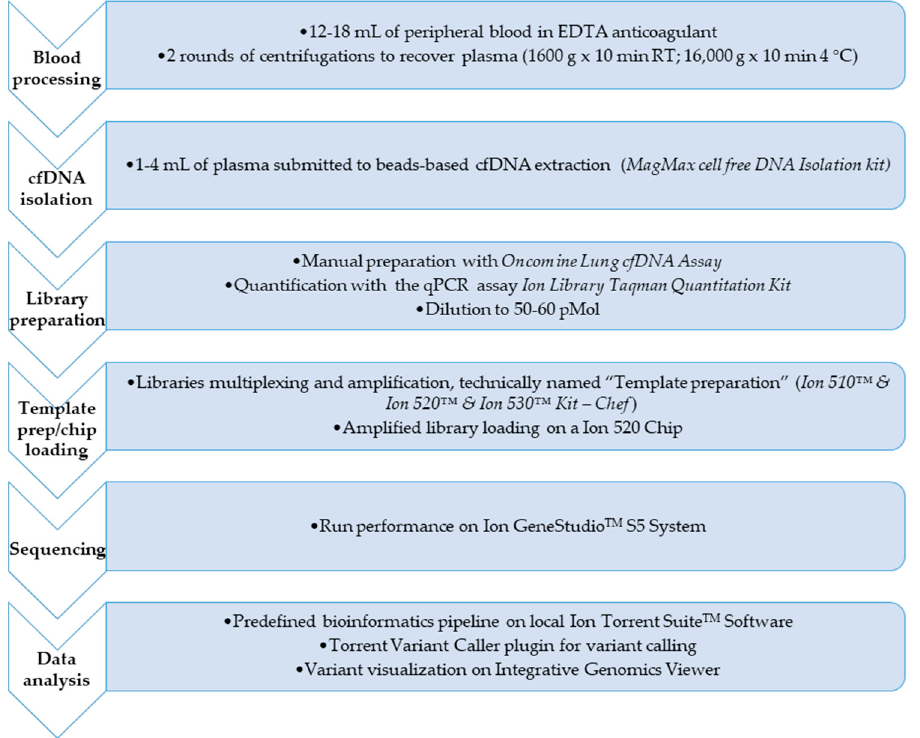
Figure 1. Flowchart of the complete workflow for circulating tumor DNA (ctDNA) next-generation